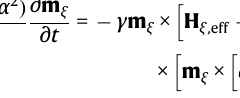
Fig. 2 | AHE and current-induced switching in Mn 3 Sn with varying MgO thick- ness. a Field dependence of Hall resistance of Ta(2)/MgO( t MgO )/Mn 3 Sn(12) at varying t MgO from 0 to 6nm. b , c Current dependence of Hall resistance of Ta(2)/ MgO( t MgO )/Mn 3 Sn(12)atvarying t MgO from0to6nmwithanin-planeassistant fi eld